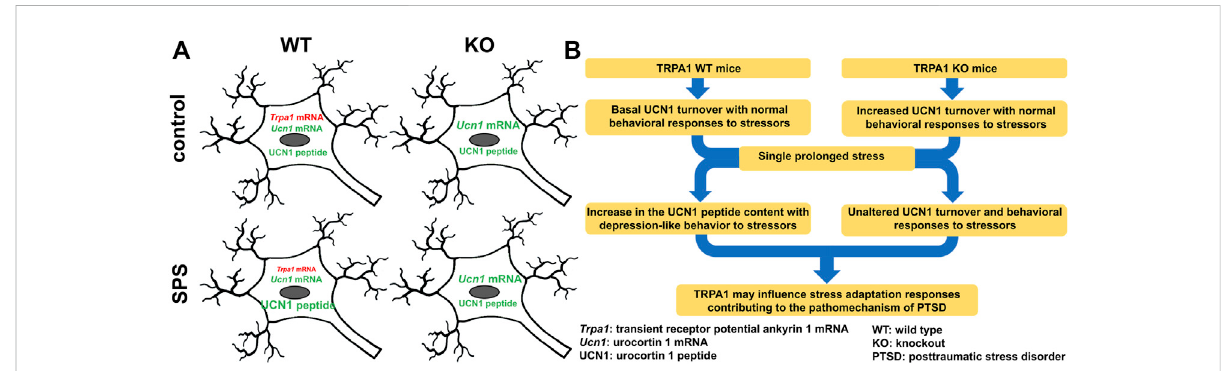
FIGURE 7 Functional-morphological (A) andgraphical (B) summaryofchangesintheurocortinergiccentrallyprojectingEdinger-Westphalnucleusinthe single prolonged stress (SPS) model of PTSD in TRPA1 WT and KO